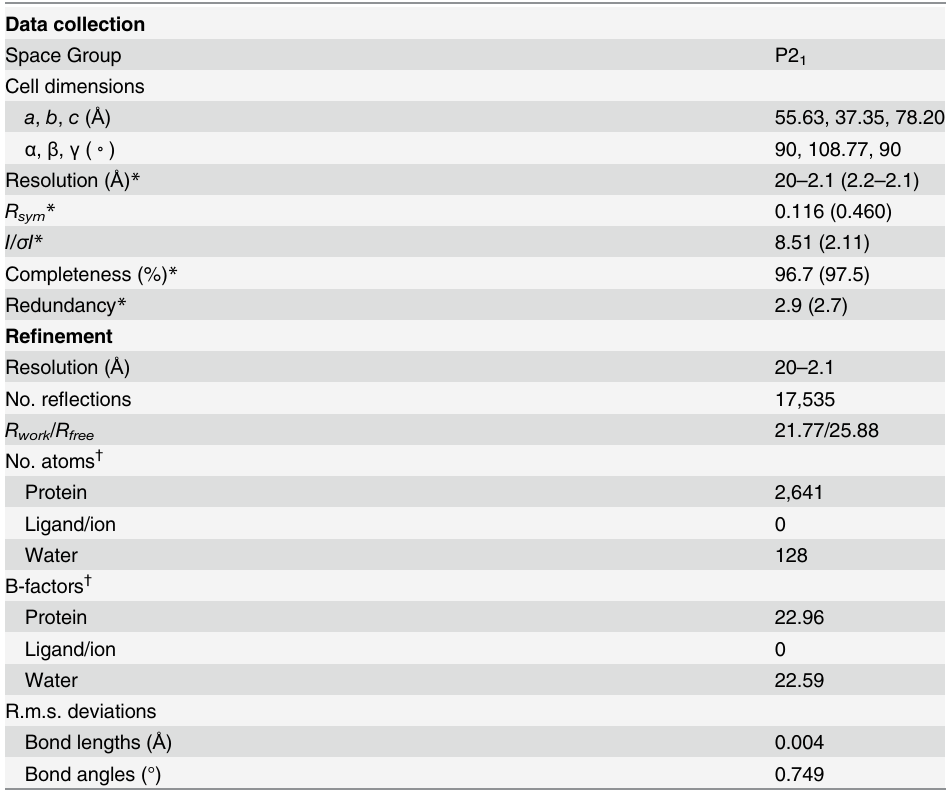
Table 1. Data collection and refinement statistics for